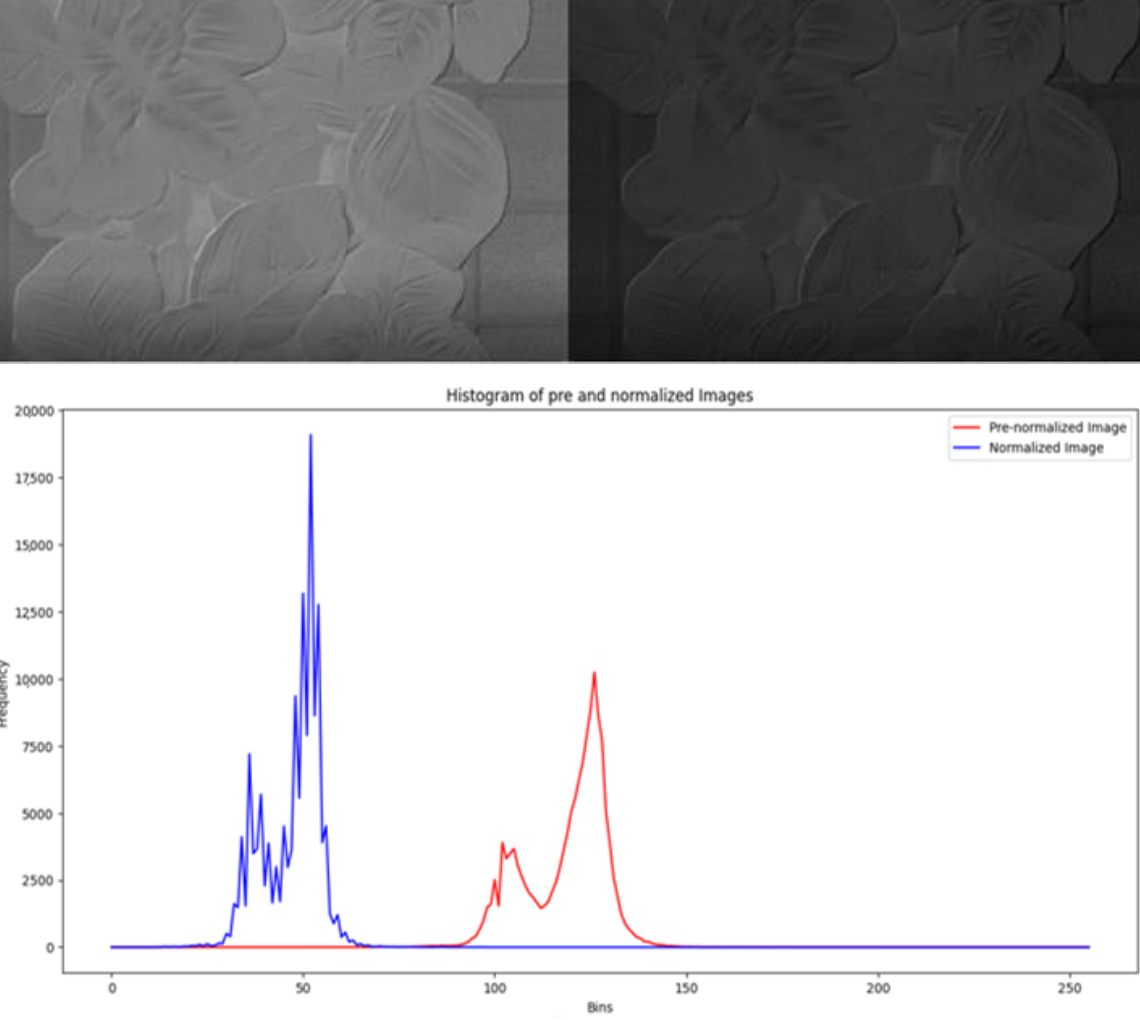
Figure 5. NDVI reflectance images of the plants from the same position before ( top left ) and after ( top right ) the normalization of the data ( bottom ).